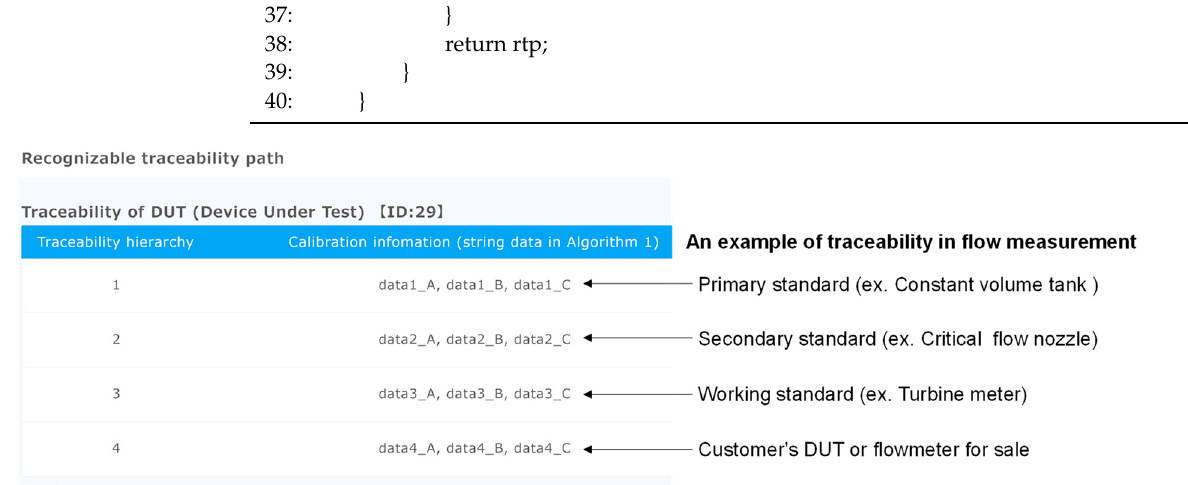
Figure 4. An example of the RTP received by an end user.